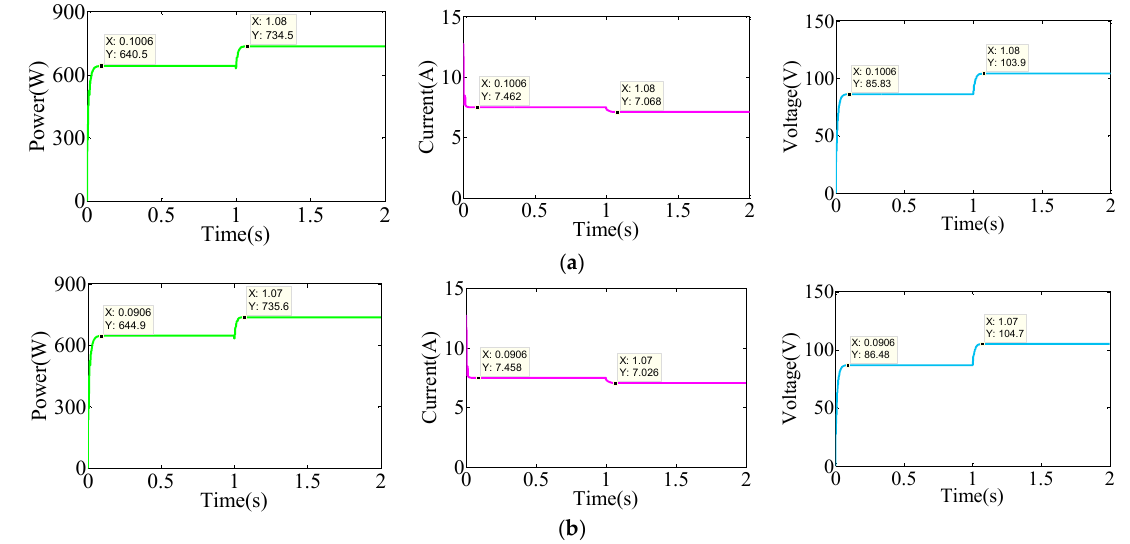
Figure 13. The output characteristics of the PV array for variable temperature conditions ( a ) P-V curve; ( b ) I-V curve.